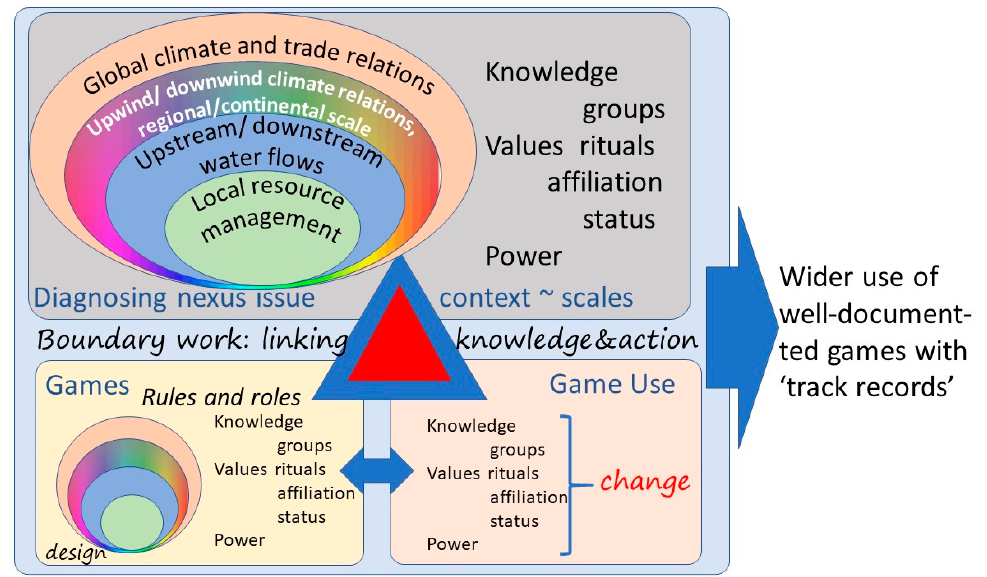
Figure 11. Real-world forest–water–people nexus issues across scale levels, games that reflect